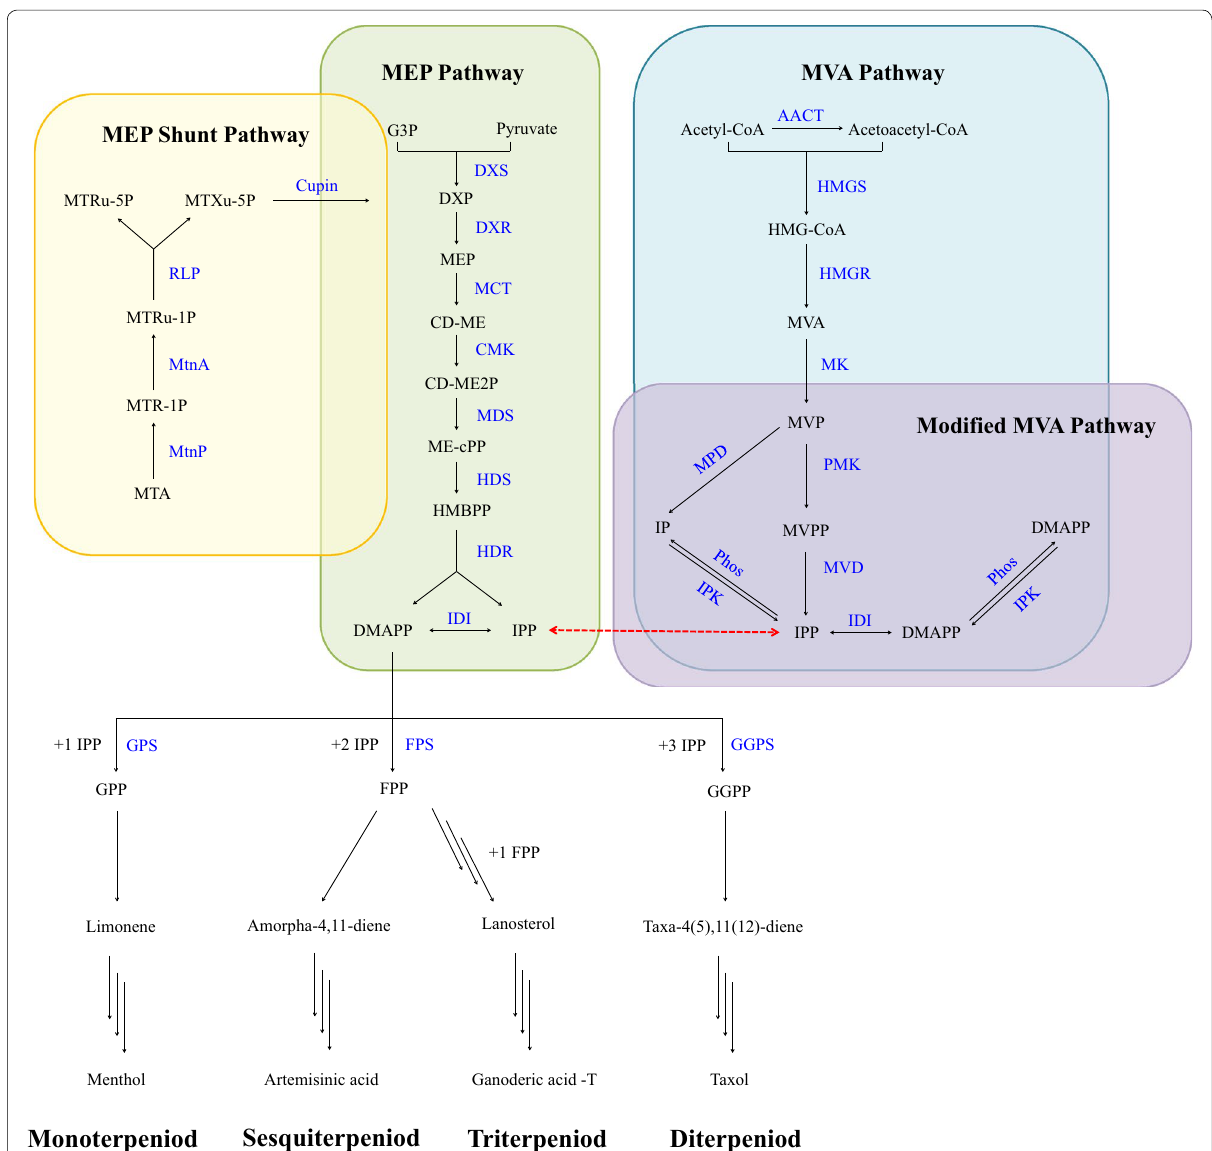
Fig. 1 Biosynthesis of IPP and DMAPP in terpenoid production. The MVA pathway, the modified MVA pathway, the MEP pathway and the MEP shunt pathway are indicated in blue, purple, green and yellow,